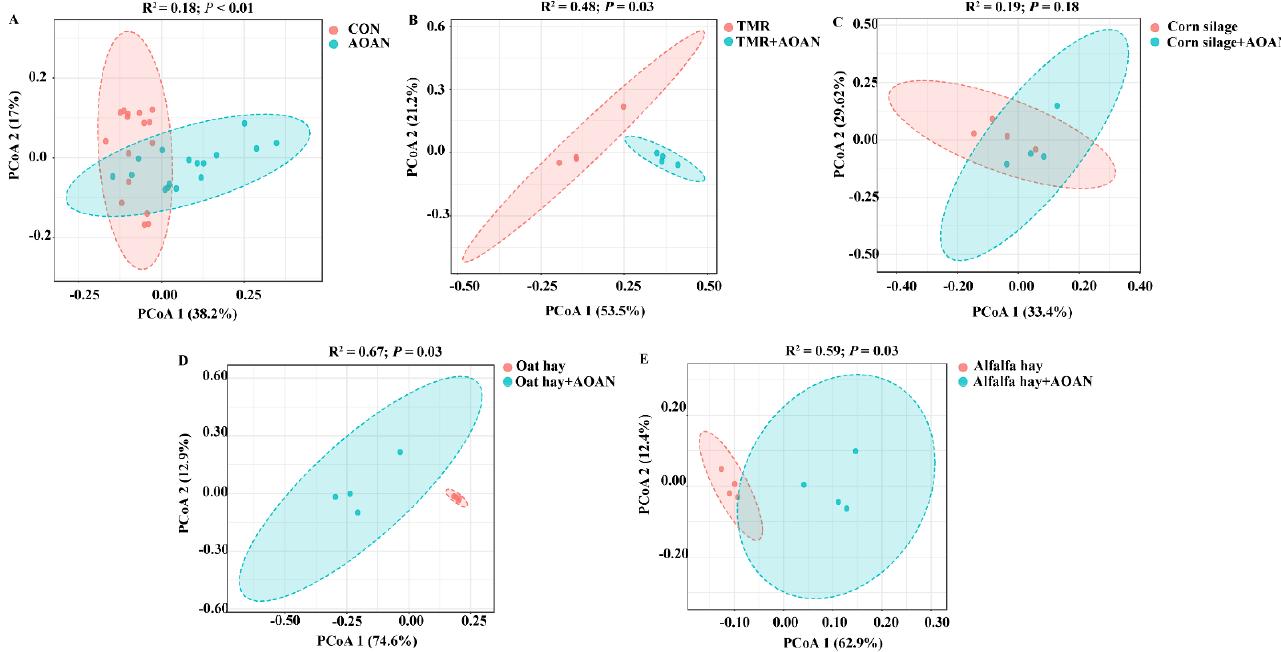
Figure 6. Effects of Aspergillus oryzae and Aspergillus niger co-cultivation fermentation extract on β diversity calculated using Bray–Curtis dissimilarity, based on OTU level of TMR ( B ), corn silage ( C ), oat hay ( D ), alfalfa hay ( E ), and all ( A ). Groups were significantly different using PERMANOVA analysis. AOAN indicates fermentation with Aspergillus oryzae and Aspergillus niger co-cultivation fermentation extract. CON group indicates all feeds without AOAN supplementation. AOAN group indicates all feeds with AOAN supplementation. TMR, total mixed ration.